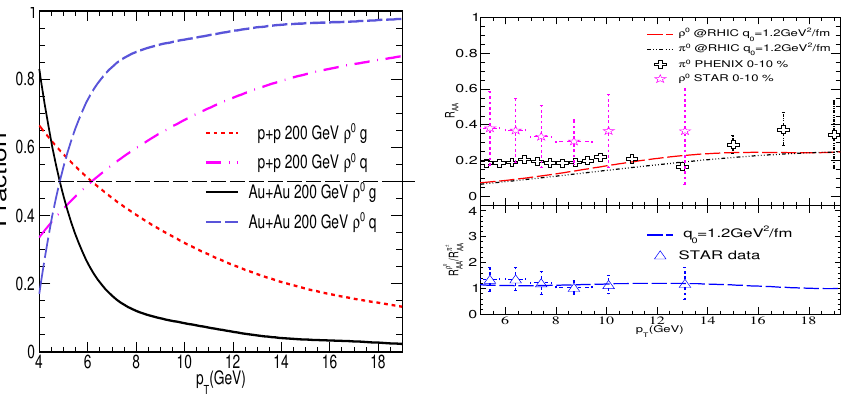
Figure 3. Left: contribution fractions of ρ 0 yield from quark and gluon fragmentations at NLO in p + p and Au + Au at √ s NN = 200 GeV [13]. Right: (top) nuclear modification factors of ρ 0 with comparison against data from STAR [25] and PHENIX [26]; (bottom) double ratio of R ρ 0 NLO, with comparing against STAR